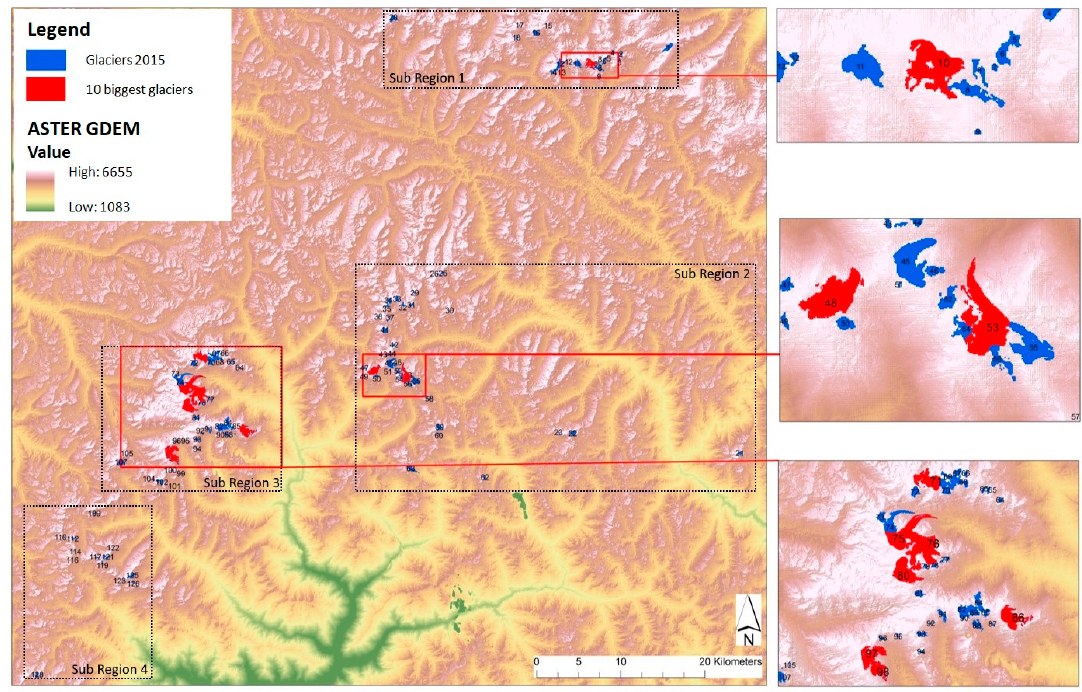
Figure 2. Headwaters region of the Ayeyarwady River with all identified glaciers in 2015 including the location of the 10 largest glaciers, and sub-regions mentioned in the text.